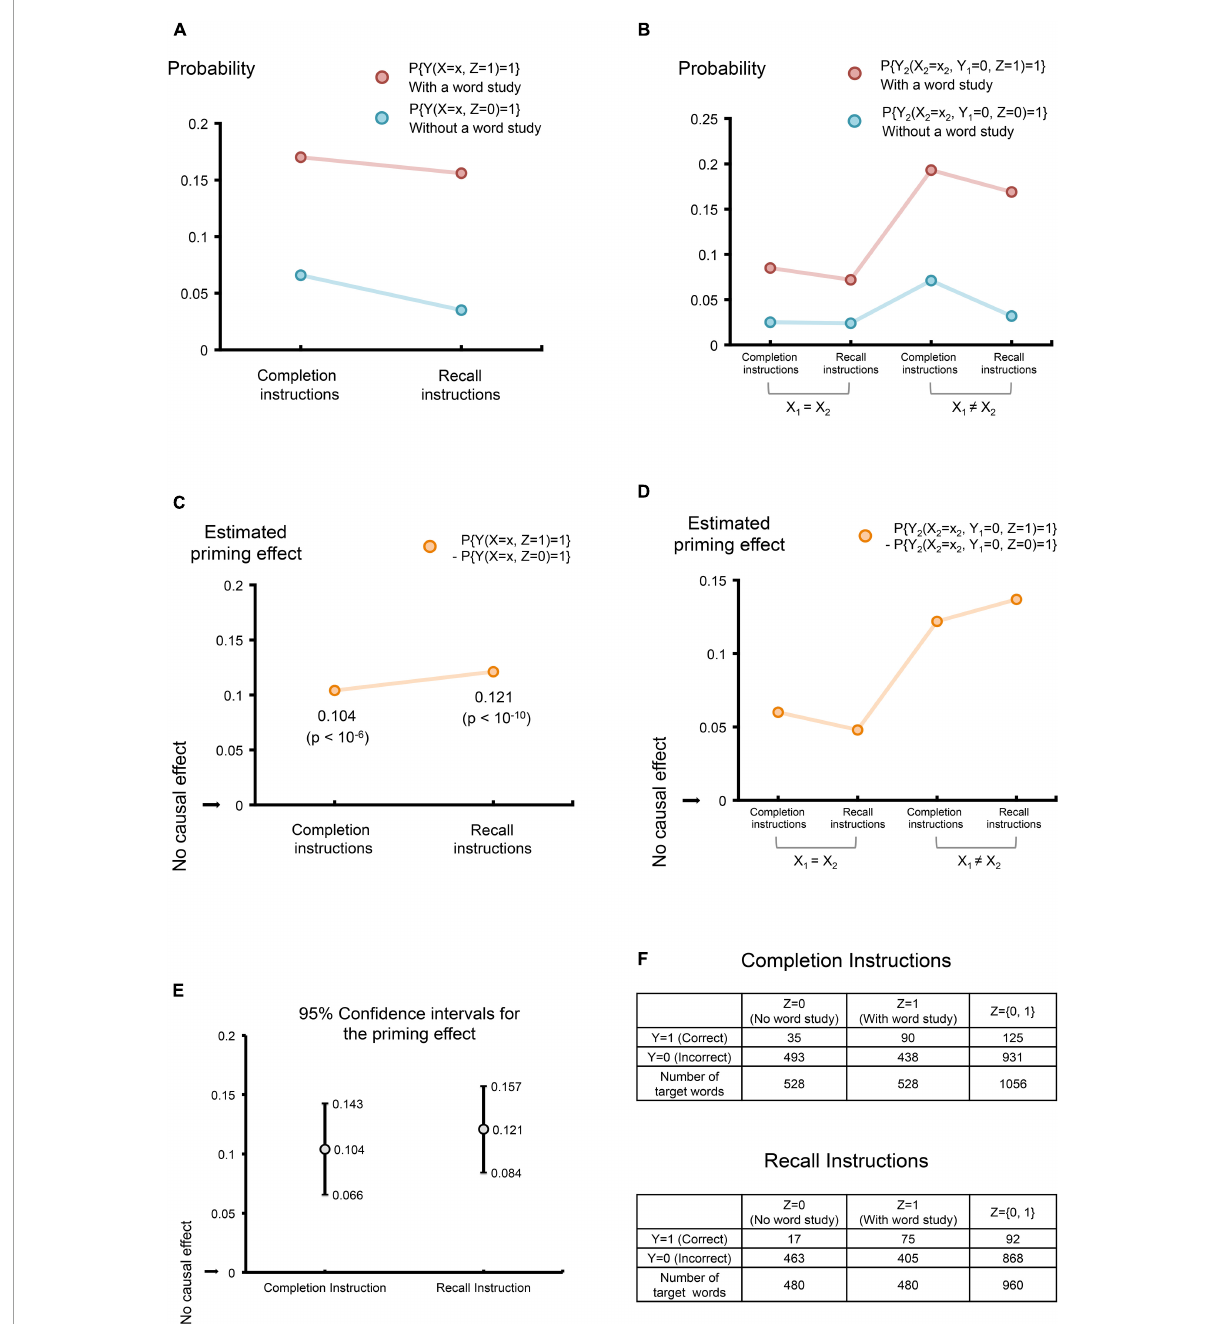
FIGURE4 Estimating the causal priming effect. (A) Probabilities of correctly uncovering target words given fractional cues, under the completion instructions and the recall instructions. The color red is used to indicate experiments involving a word study including target words; the color blue is used to indicate experiments involving a word study without target words (abbreviated as “without a word study”). (B) The probabilities of correctly uncovering target words during a second cue-based test, given that the first test failed to uncover the same word. Four experimental sceneries were considered, combining two instruction strategies: the completion instructions and the recall instructions, and two types of cues: the same cues and different cues during two tests. X 1 and X 2 refer to cues from the first test and the second test, respectively; X 1 = X 2 indicates the same cues were used in the two tests; X 1 (cid:54)= X 2 indicates different cues were used in the two tests. Again, the color red is used to indicate experiments involving a word study including target words; the color blue is used to indicate experiments involving a word study without target words (abbreviated as “without a word study”). (C) The estimated causal priming effects and their p -values correspond to (A) . (D) The estimated causal priming effects correspond to (B) . (E) The estimated 95% confidence intervals for the priming effect in (C) . (F) Data used in estimating the priming effect corresponding to (A,C,E) . Data adapted by permission from RightsLink Permissions American Psychological Association “Is priming in fragment completion based on a ‘traceless’ memory system?” by Hayman and Tulving (1989), American Psychological